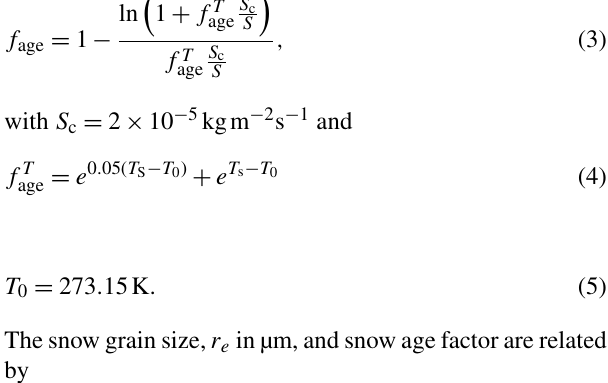
Figure 6. Seasonal evolution of several modelled variables at 15ka at two locations at the southern margin of the Laurentide (left) and Fennoscandian (right) ice sheets for the reference simulation (black lines) and from offline simulations with no dust deposition (blue), no snow aging (red), and no dust deposition and no snow aging (green). The variables shown are (a) snow water equivalent, (b) sur- face albedo, (c) snow grain size, (d) dust concentration in snow, (e) ablation and (f) ice melt. The location of the two sites is indi- cated by the red boxes in Fig.